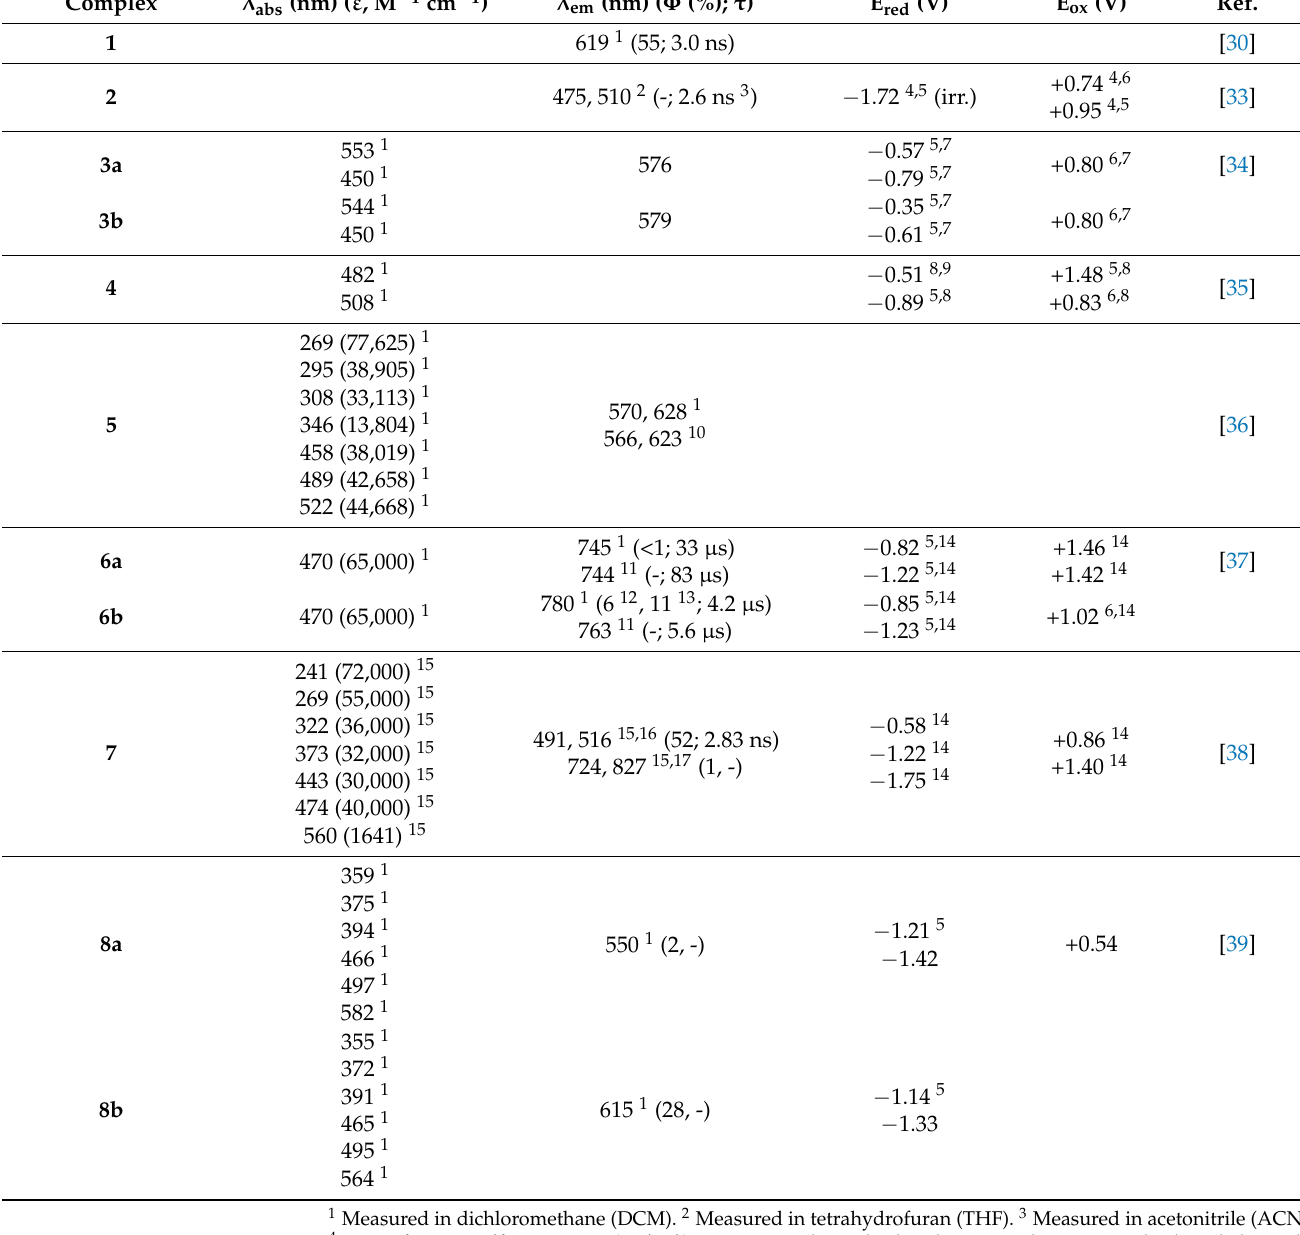
Table 1. Photophysical and redox properties of complexes 1 , 2 , 3a – b , 4 , 5 , 6a – b , 7 , and 8a – b